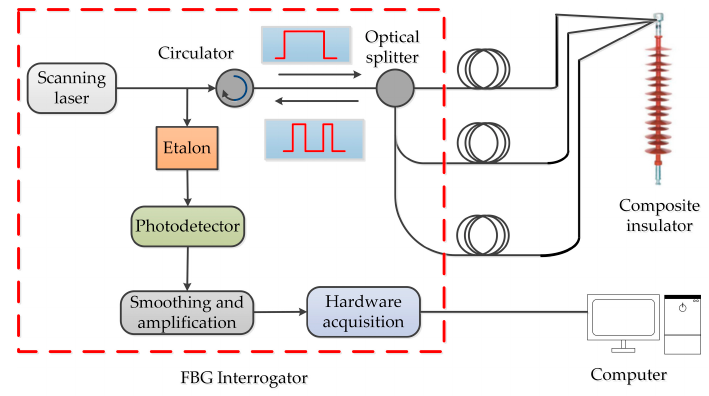
Figure 4. The system diagram of glaze icing detection of a composite insulator with embedded FBG.